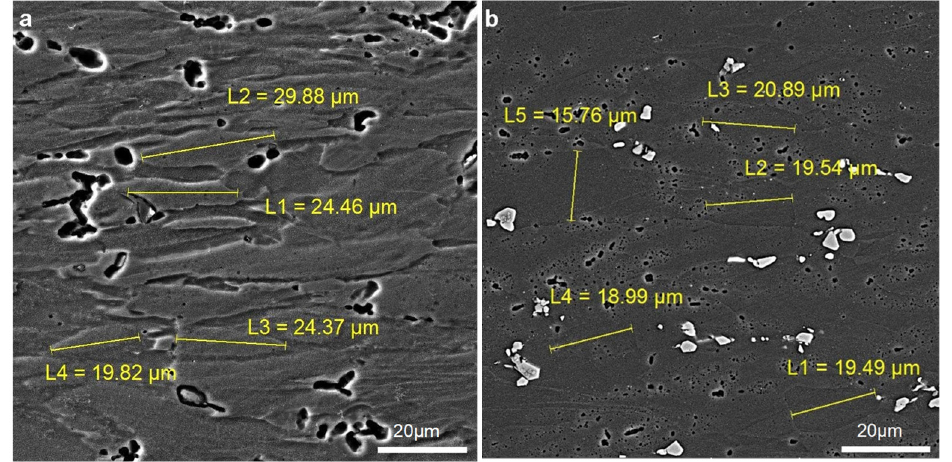
Figure 4. Grain size in alloy containing 0.1% Sc under two thermomechanical treatments with 50% deformation: ( a ) thermomechanical treatments with conventional dissolution, and ( b ) thermome- chanical treatments with controlled quenching at 120 °C for 12 h.